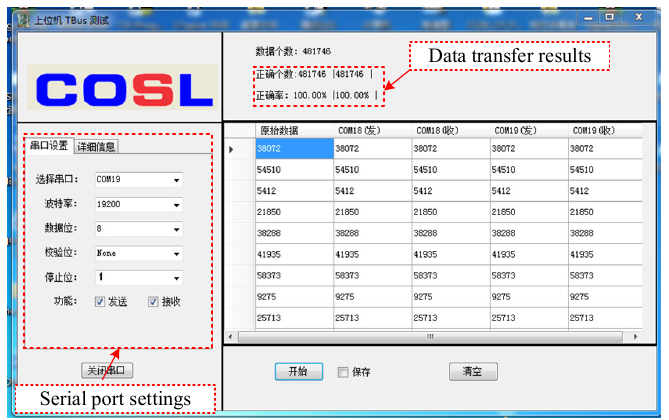
Figure 9. The bit error rate test results of data transfer.